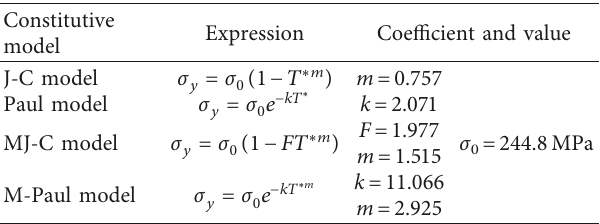
Table 1: Constitutive model and material parameters at yield point at different